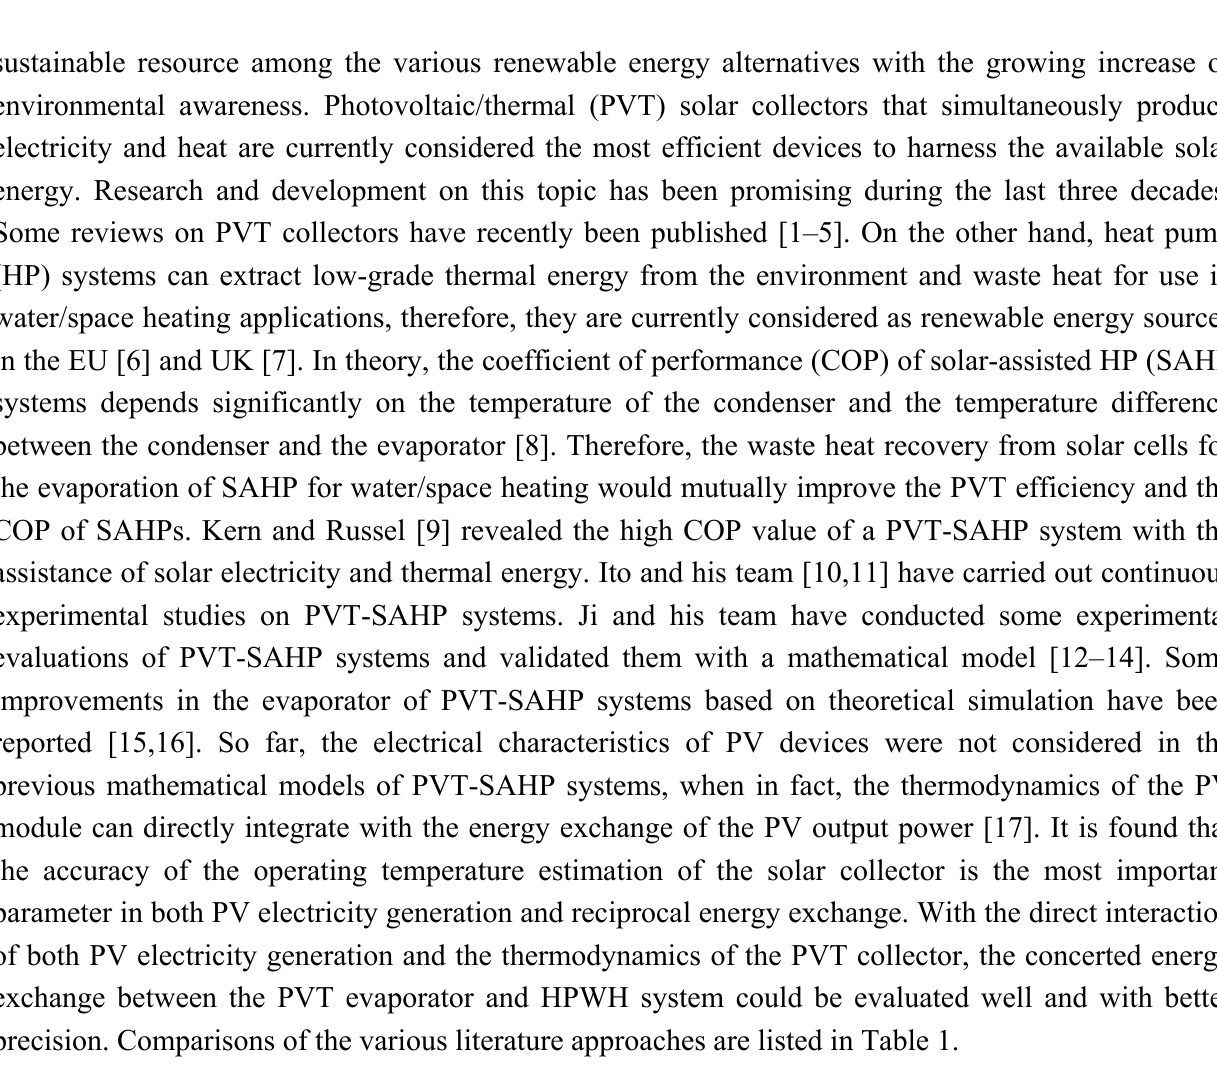
Table 1. Comparisons among PVT mathematical